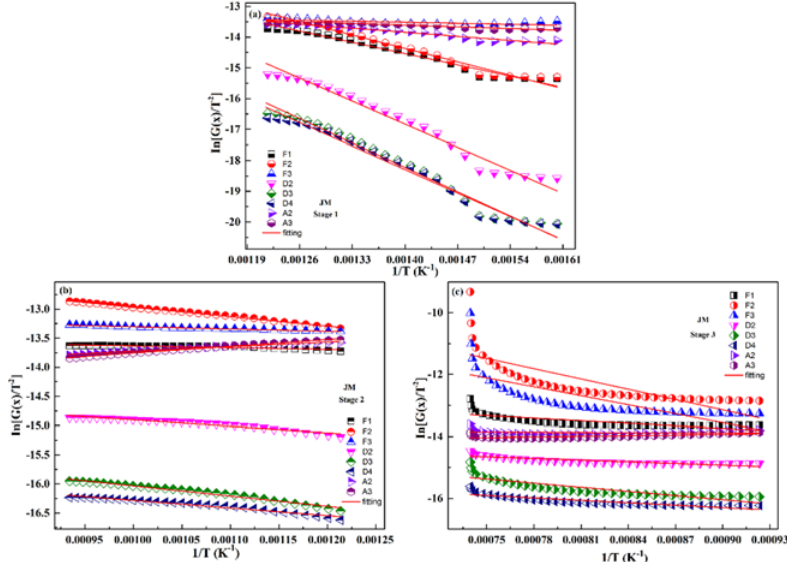
Figure 6. Linear fitting of the mechanism function during the different stages of the JM pyrolysis reaction: ( a ) linear fitting of the mechanism function at reaction stage 1, ( b ) linear fitting of the mechanism function at reaction stage 2, ( c ) linear fitting of the mechanism function at reaction stage 3. Table 7. Kinetic parameters of the JM briquette using different mechanism functions.